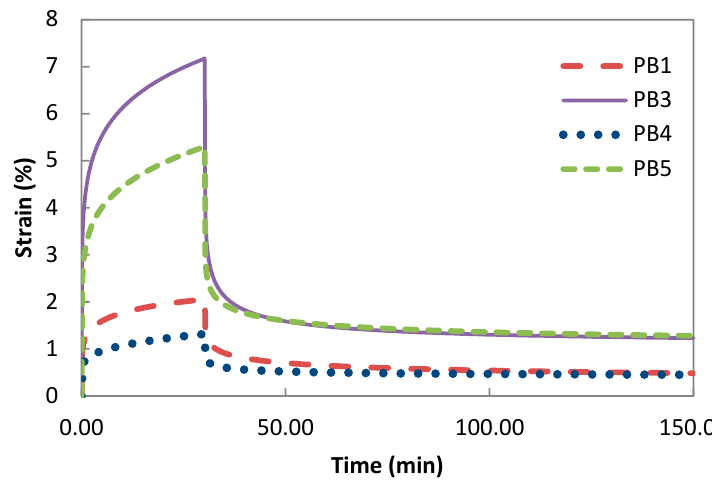
Figure 3. The effect of compatibilizer (MA- g -PE) on creep-recovery behaviour.